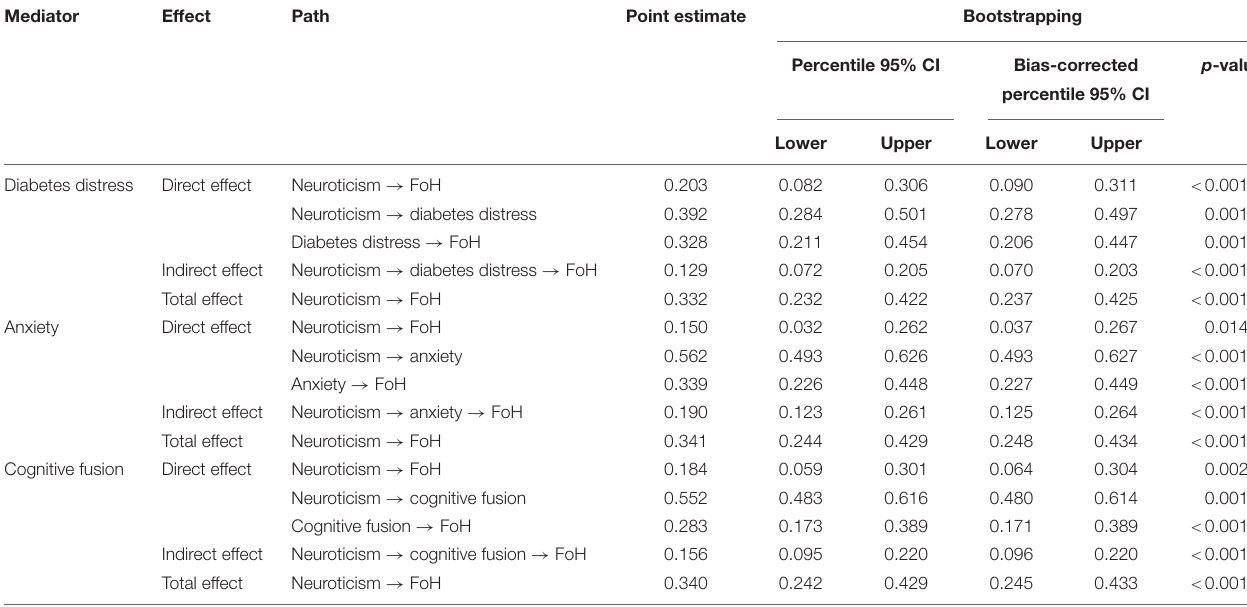
TABLE 5 | Direct, indirect, and total effects of the separate mediation model with mediator of diabetes distress, anxiety, and cognitive fusion.